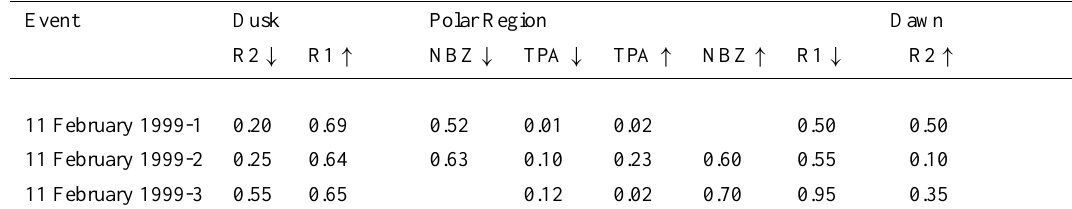
Table 3. Modelled field-aligned current values (MA) for 11 February 1999. Event Dusk Polar Region